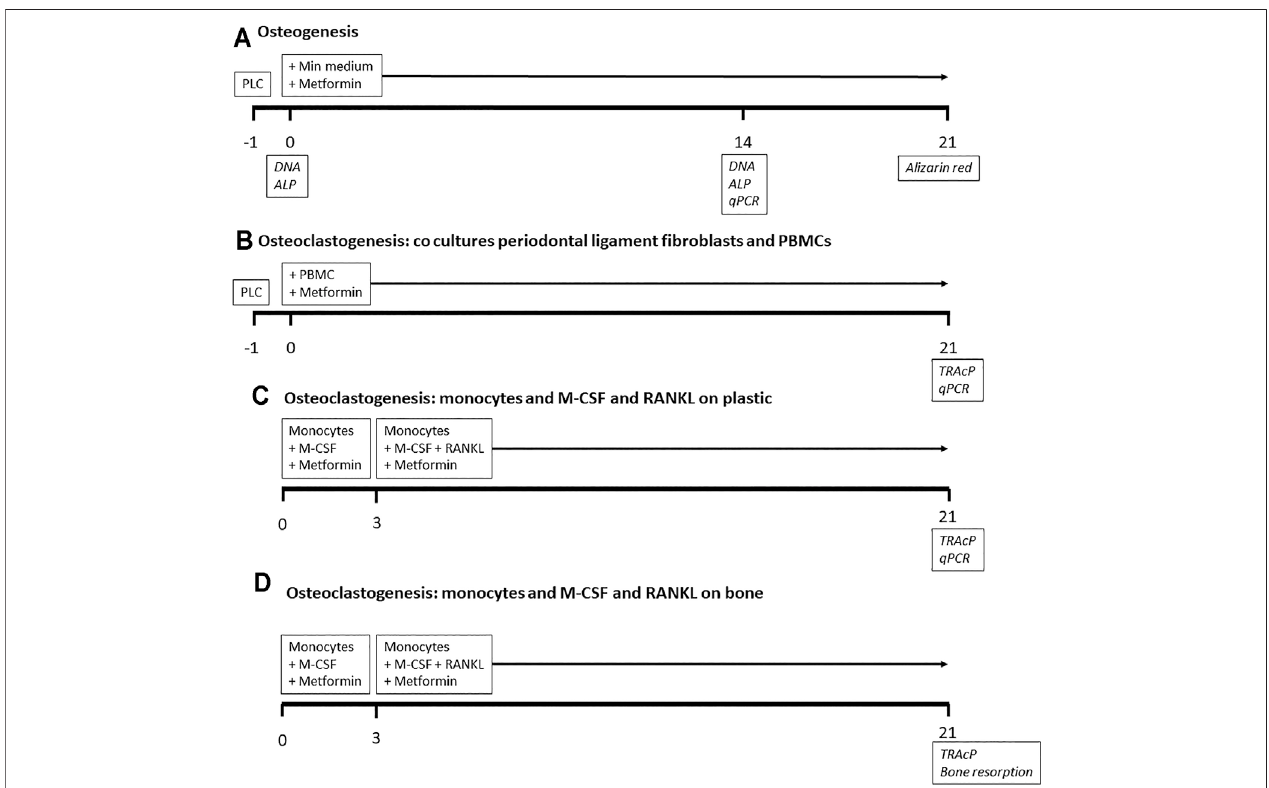
FIGURE 1 | Outline of experiments. Timeline in days. For osteogenesis and osteoclastogenesis co culture experiments, periodontal ligament cells (PLC) were cultured1 day beforethestartoftheexperiment. Metforminwasaddedthroughoutall experiments. Analysesinitalics atthedays ofsampling. PBMCs: peripheralblood mononuclear